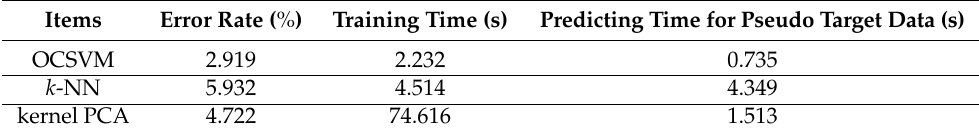
Table 2. The performance comparison of OCSVM, k -NN and kernel